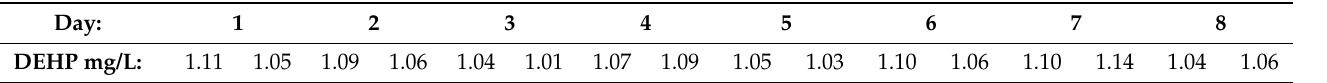
Table 5. Precision test